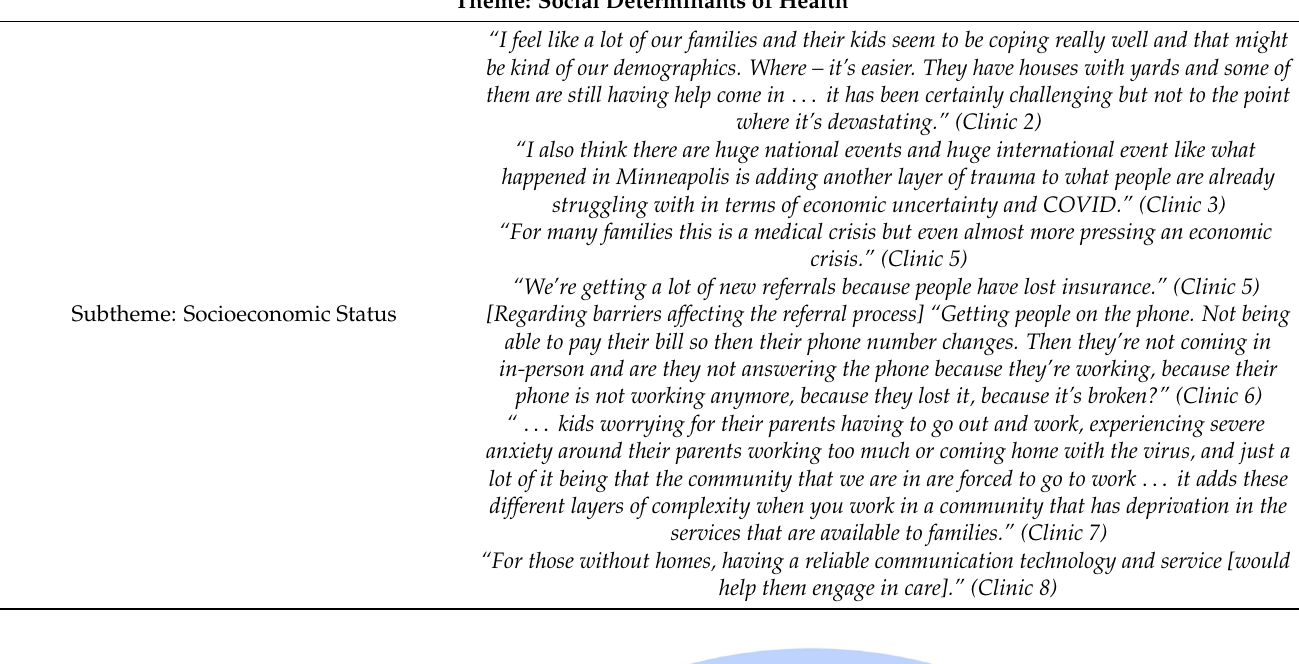
Table 2. Cont. Theme: Social Determinants of Health